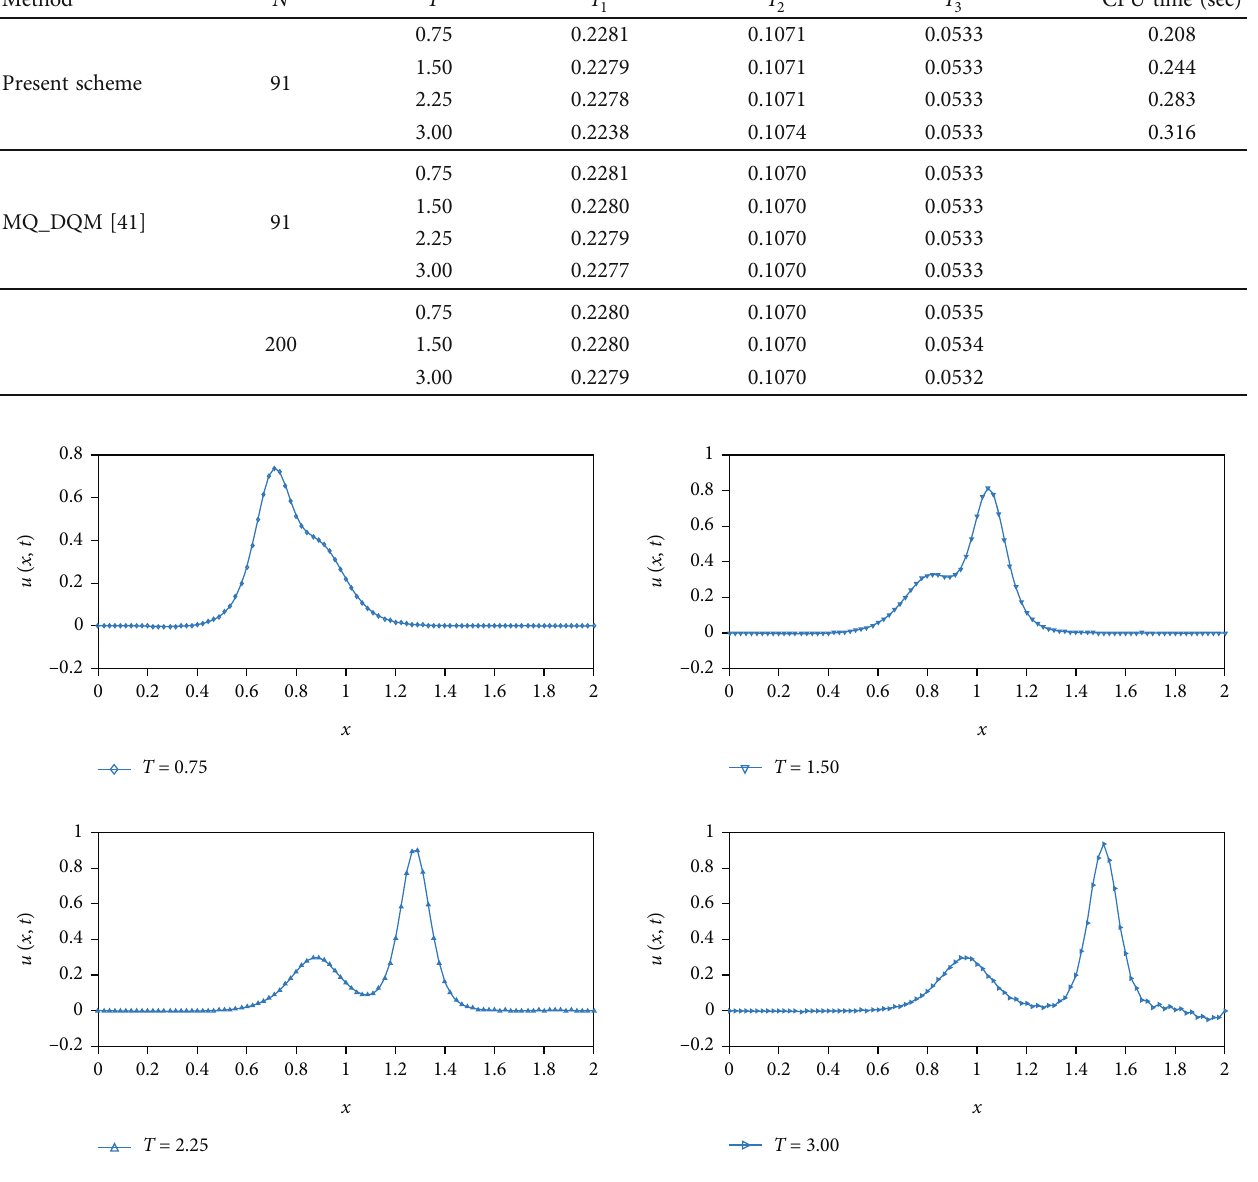
Figure 3: Simulations of two solitons: Δ t = 0 : 005